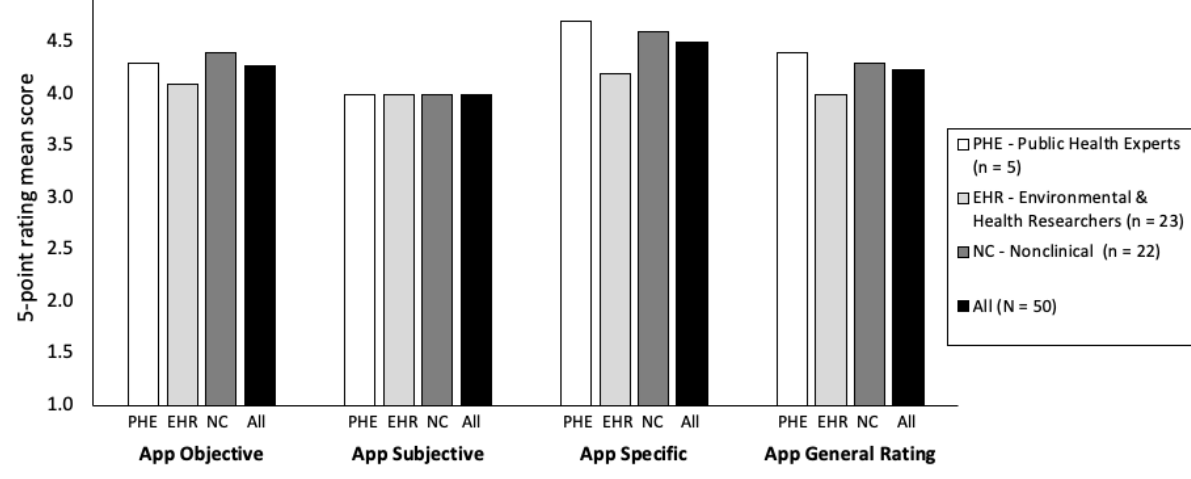
Figure 4. Mean scores of app objective, subjective, specific, and general rating based on the Mobile Application Rating Scale (MARS) from public health experts, environment and health-related researchers, and nonclinical